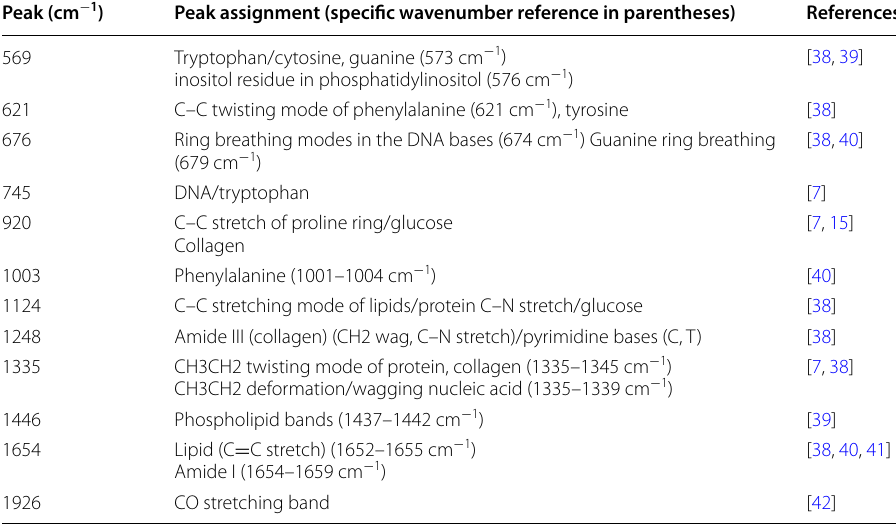
Select Raman peaks associated with quantification, tentative peak assignments, and references